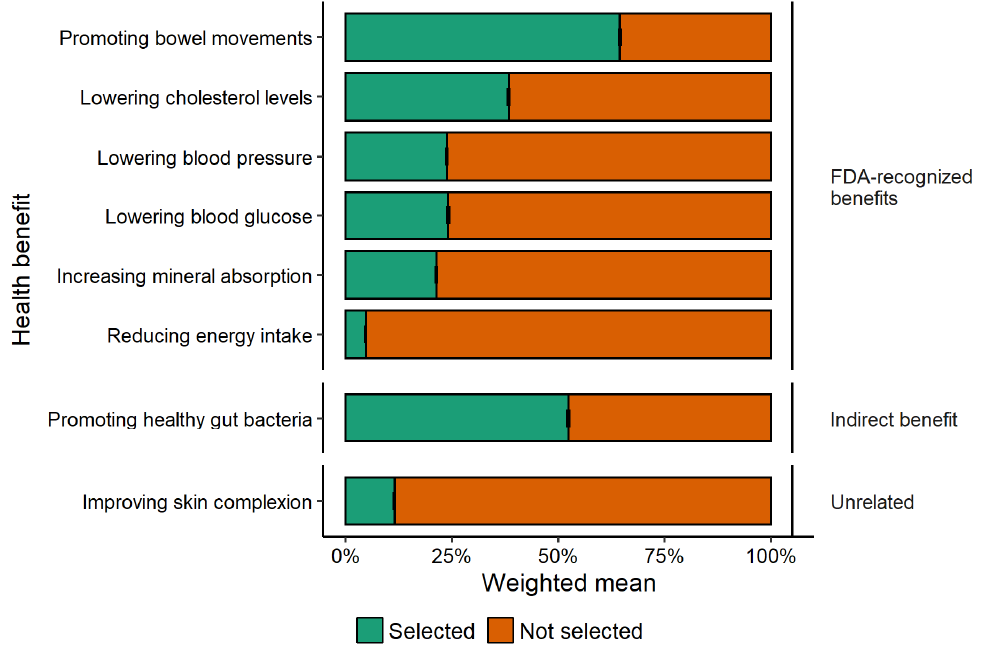
Figure 1. Proportion of respondents that selected or did not select FDA-recognized health benefits of dietary fiber, an indirect benefit, and one unrelated benefit in the IRi survey; error bars show 95% confidence interval ( n = 42,018); some error bars may be too close to the mean to see. In the IRi survey, respondents selected only 1.77 (95% CI = 1.76–1.77) FDA-recognized benefits out of a total of six. More than 1 in 5 participants selected none of the FDA- recognized health benefits and over 50% of respondents selected zero or only one recognized benefit (Figure 2). Only 2.3% of respondents correctly perceived all six recognized health benefits. The proportion of individuals that consider fiber when making food choices increased with each additional benefit selected from only 9% of those that identified no benefits of fiber to 58% of those that identified all six FDA-recognized benefits of